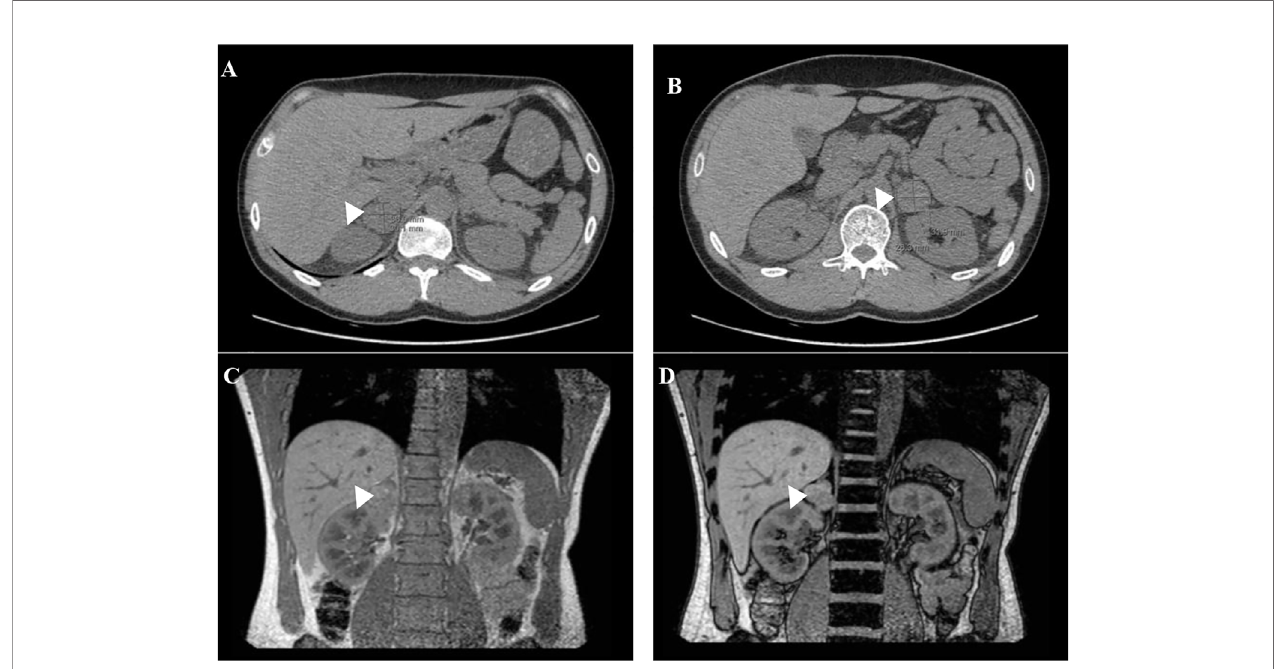
FIGURE 2 | Abdominal-CT (A, B) and MRI scan (C, D) before bilateral adrenalectomy: adrenal lesions on the right (A) and left (B) adrenal gland. Coronal in-phase (C) and out-of-phase (D) MRI images with no loss of signal in the